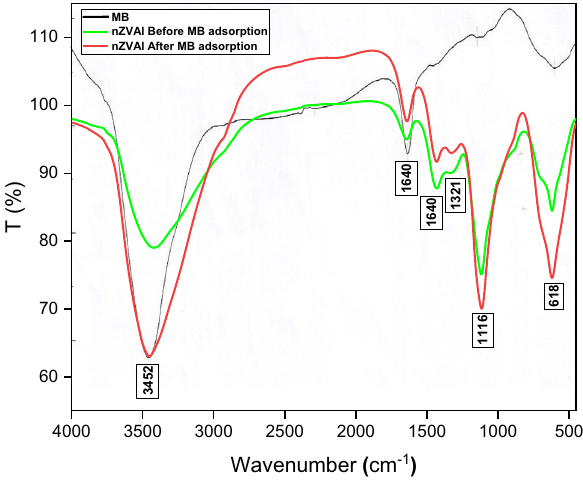
Fig. 3 IR spectra of MB and nZVAl before/after MB